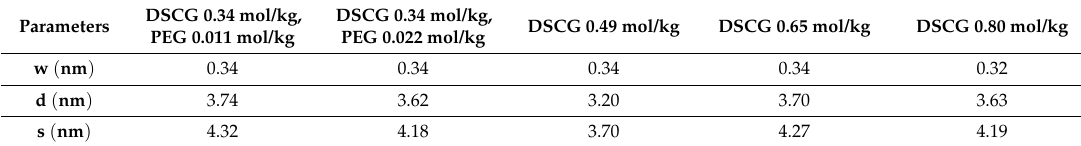
Table 1. Comparison of stacking distance w nm, lateral distance d nm, and distance between the centers of neighboring columnar stacks s nm for each mixture in the C phase at T = 46.0 ◦ C.